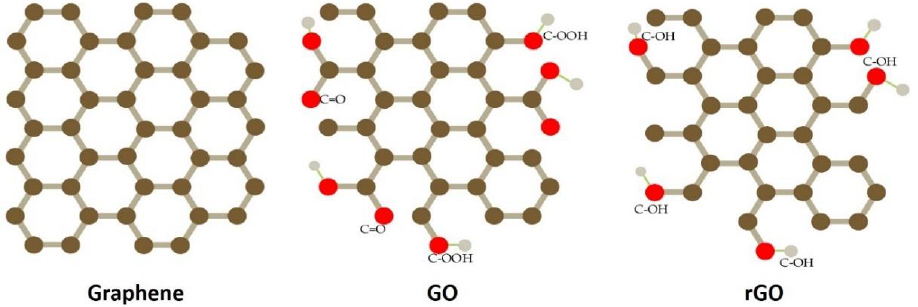
Figure 3. The schematic diagram of the structure of graphene, GO, and rGO. Reproduced from ref. [64].